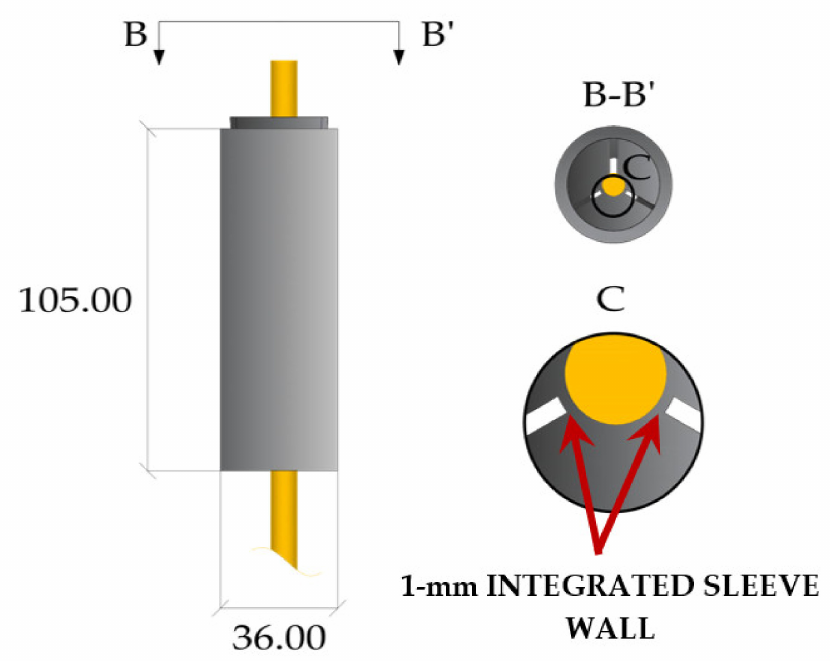
Figure 11. Split wedge anchorage devised by Schmidt et al. [25] with an integrated sleeve (dimensions in millimeters).